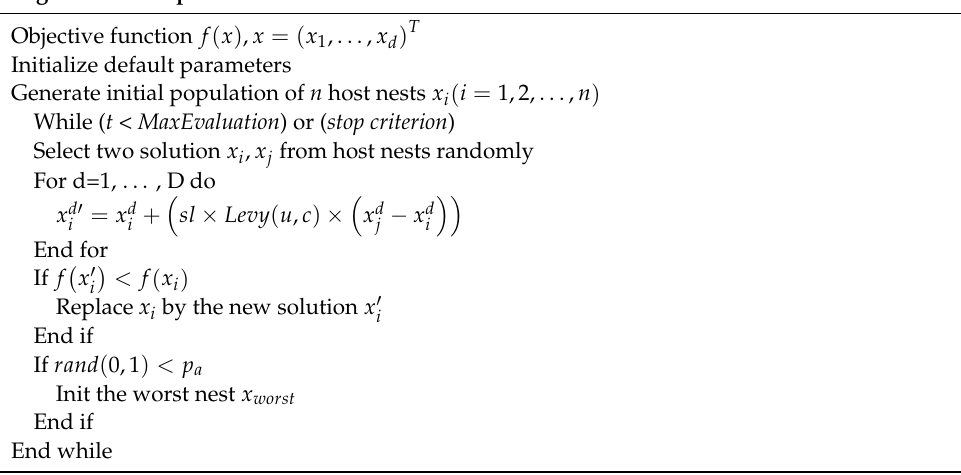
Algorithm 1. Improved cuckoo